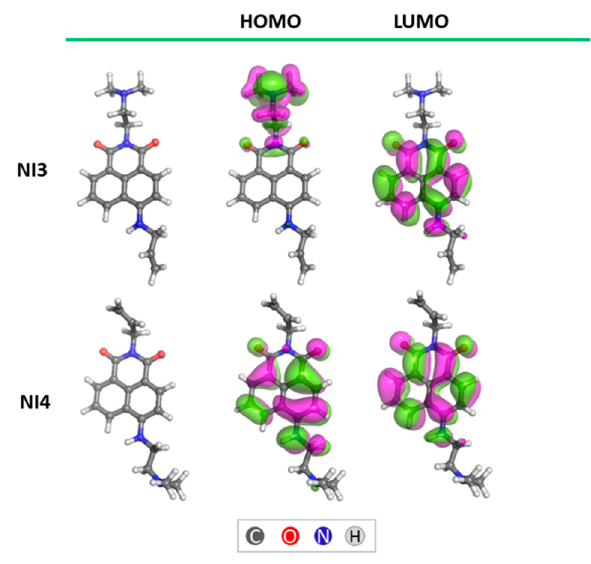
Figure 5. Optimized structures and graphical representation of the frontier orbitals (isodensity plot, isovalue = 0.02 a.u.). Table 3. Time-Dependent Density Functional Theory—p.3 (TDDFT) / PBE0 calculated absorption maximum ( λ max ) and oscillator strength for compounds NI3 and NI4 in selected solvents with di ff erent